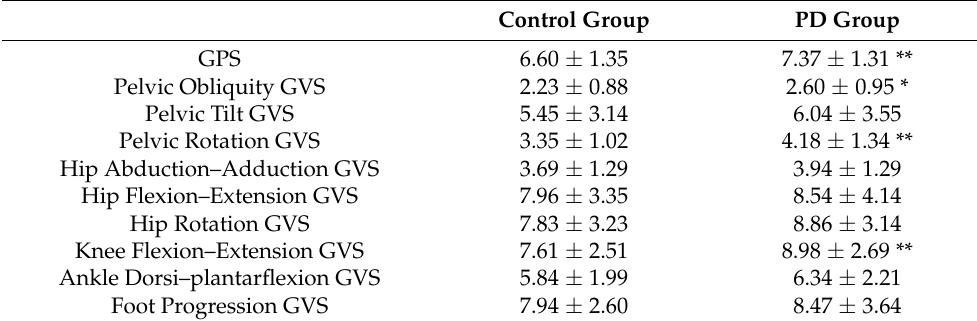
Table 4. GPS and GVS indexes (in degrees). Values are expressed as mean ± SD.